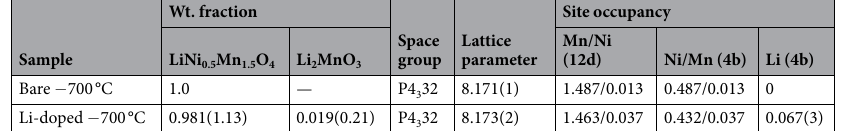
Table 1. NPD data based Rietveld refinement results of the bare − 700 °C and the Li-doped − 700